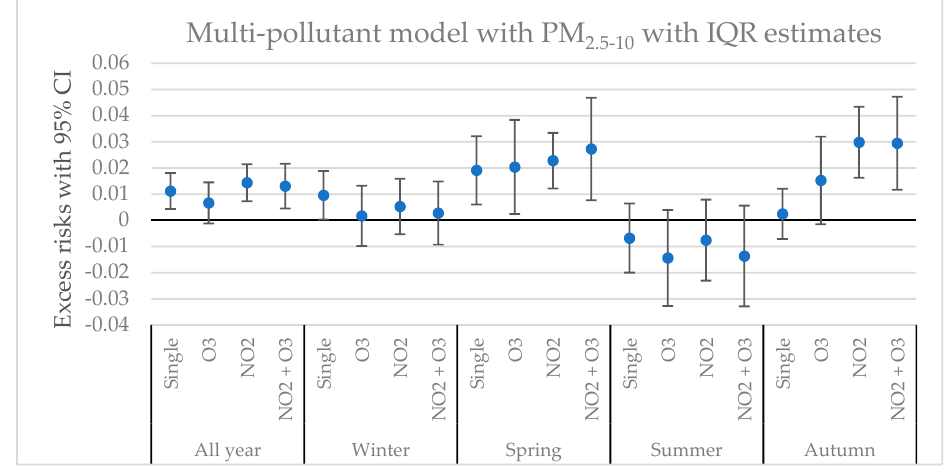
Figure 3. Estimated excess risks in daily mortality with 95% CI (lag02) for an IQR increase in the concentrations of PM 2.5–10 . The calculations are divided into all year and four different seasons. The excess risks are presented as single ‐ pollutant estimates and multi ‐ pollutant estimates with O 3 , NO 2 and NO 2 + O 3 included in the calculations.